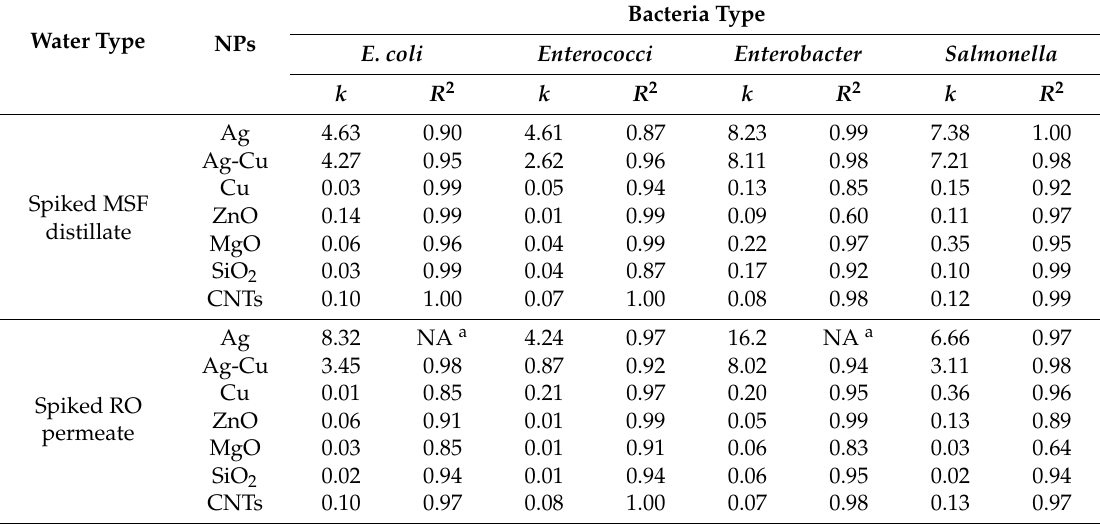
Table 9. Values of k (L/mg · min) for all investigated